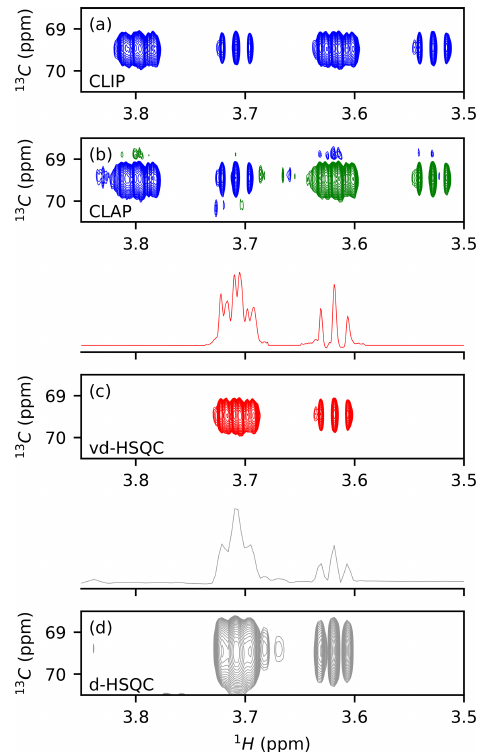
Figure 1. Application of virtual decoupling isolated dextran oligosaccharide. CLIP (a) and CLAP (b) are shown with positive contours in blue and negative contours in green. (c) Virtually decou- pled HSQC. (d) Decoupled HSQC. The traces shown above pan- els (c) and (d) are extracted at the centre of the peak of the 2-D